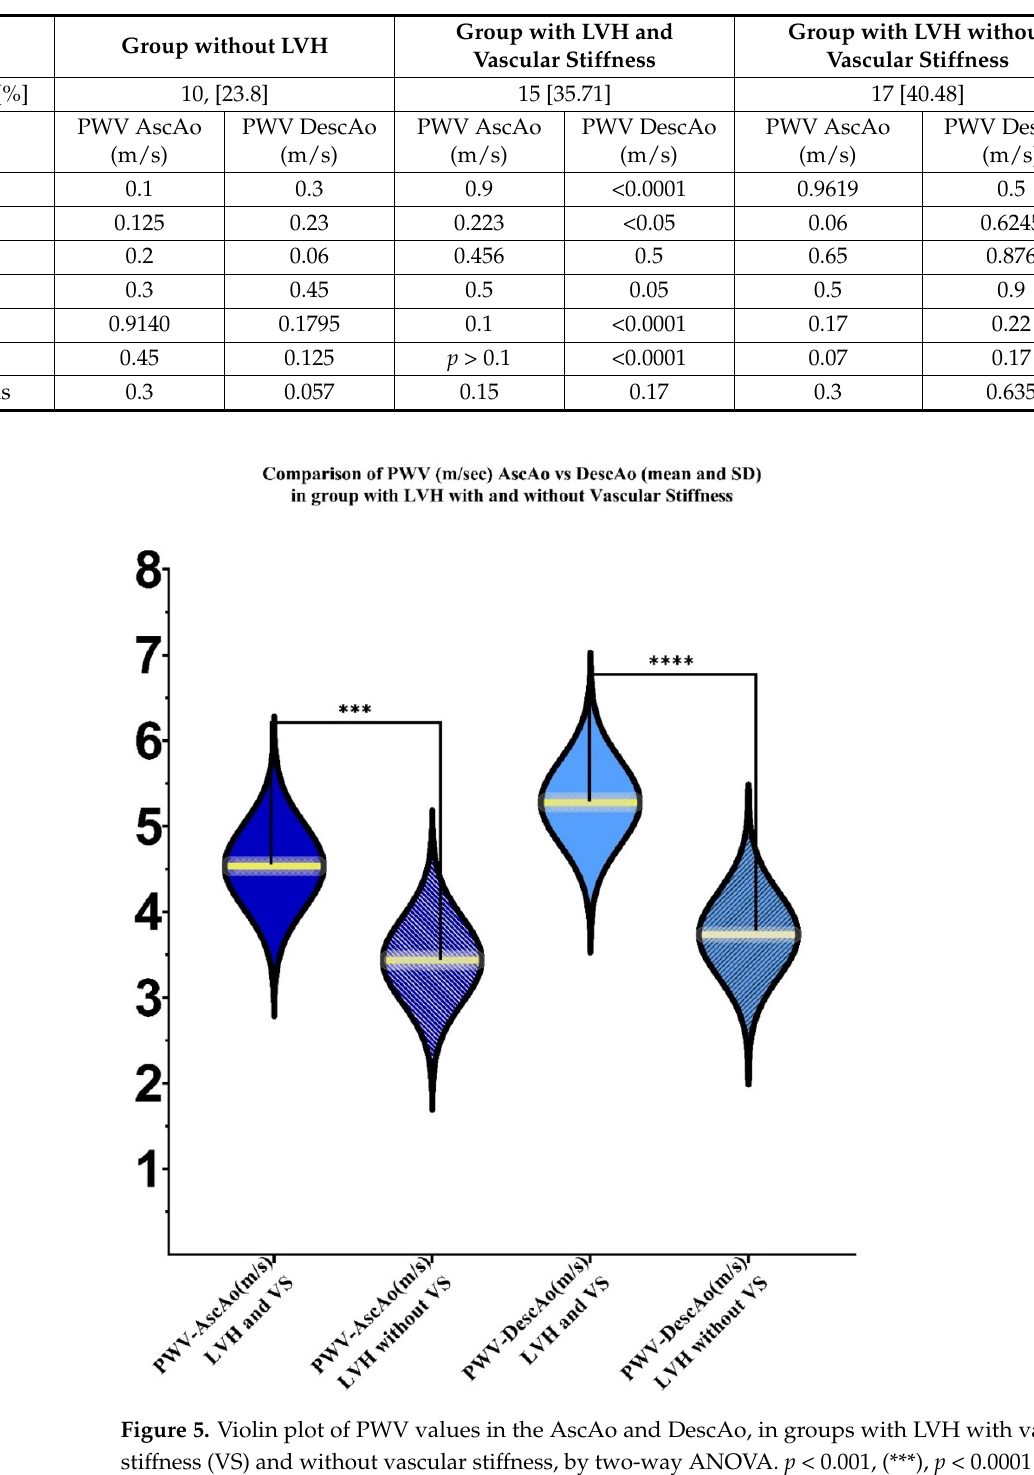
Table 3. Pearson’s correlation coefficients for PWV in the groups without LVH, with LVH with vascular stiffness, and LWH without vascular stiffness. Abbreviations: SBP-systolic blood pressure, DBP—diastolic blood pressure, and RRT-renal replacement therapy.